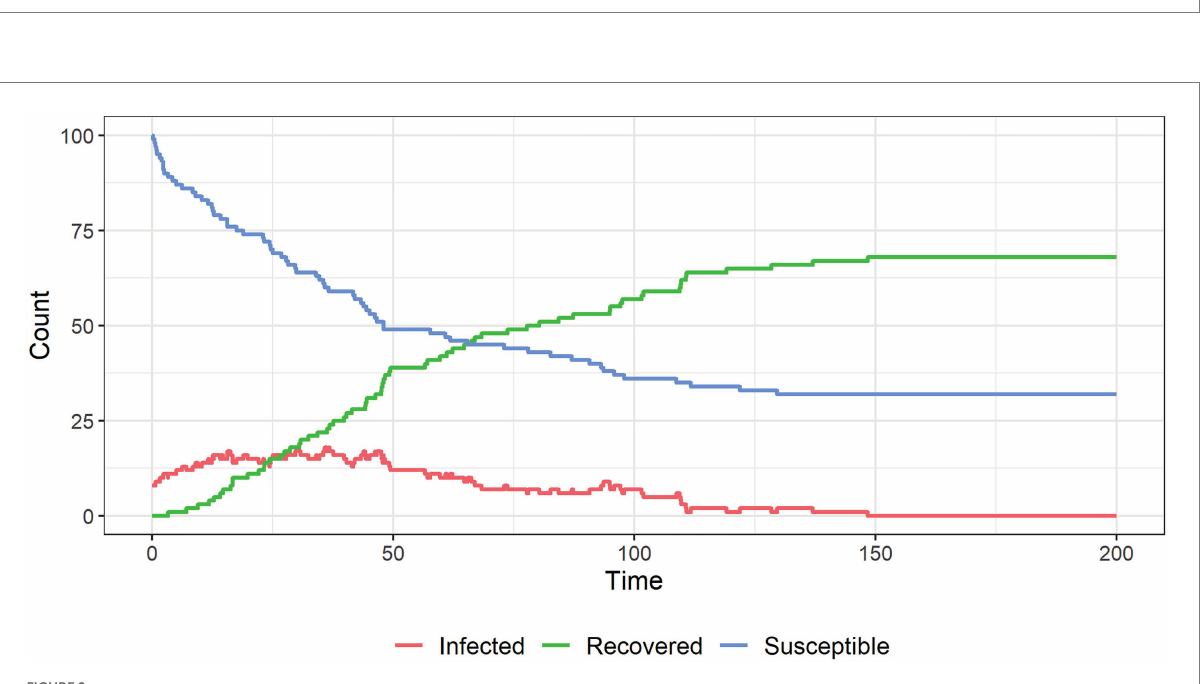
FIGURE 9 The spread of a conspiracy theory infection through a population, with cumulative social influence from non-susceptible individuals on susceptible individuals. Again, the CT dies out as believers are convinced of their error.